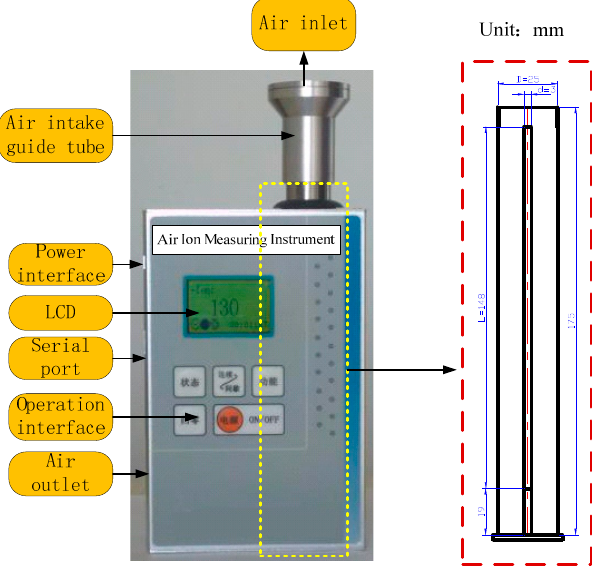
Figure 5. Picture of the sensor.